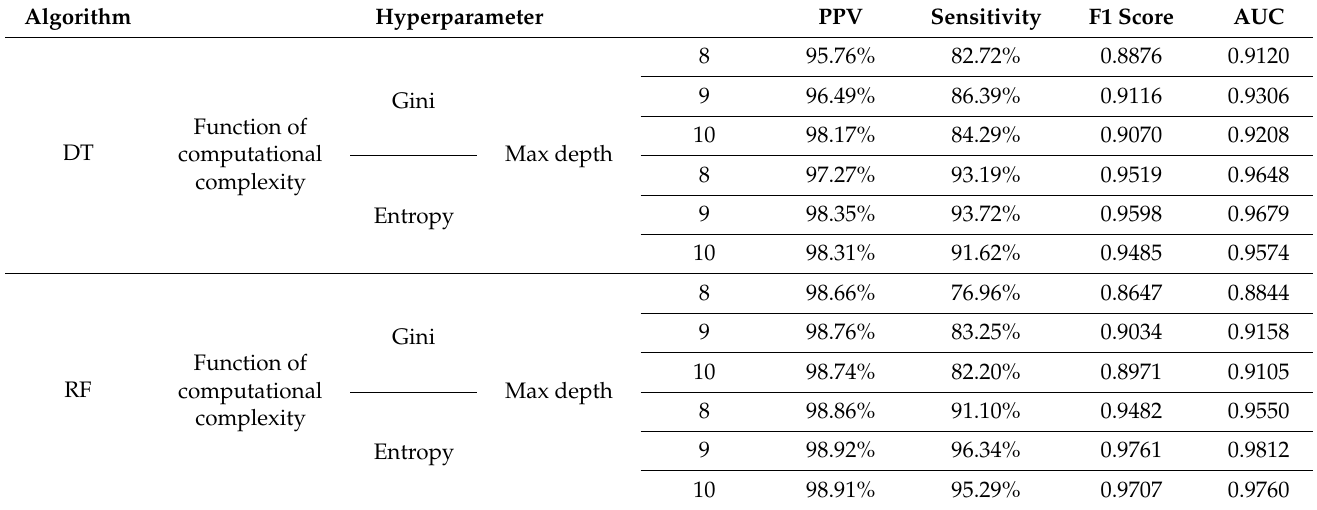
Table 8. Performance comparison of hyperparameter